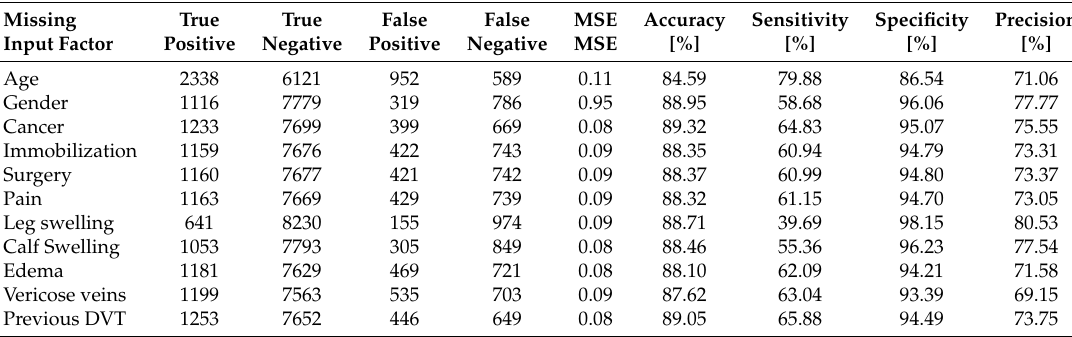
Table 8. Evaluation of the proposed ANN model without any input.